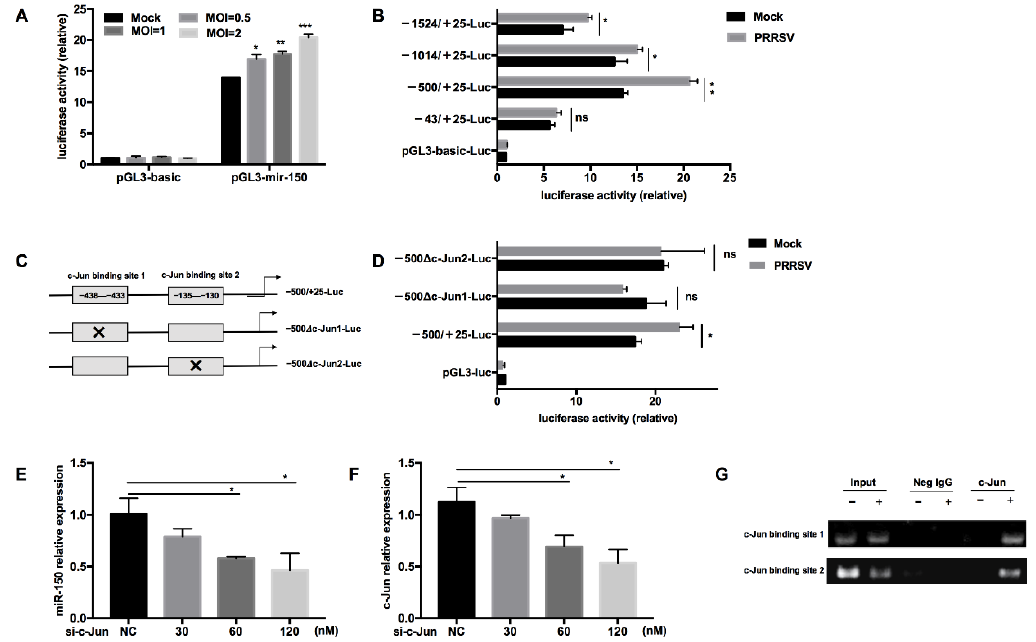
Figure 3. c-Jun is crucial for PRRSV to activate the miR-150 promoter. ( A , B ) After co-transfection of pGL3-miR-150 or truncated pGL3-miR-150 along with pRL-TK into Marc-145 cells for 12 h, cells were infected with HV-PRRSV (HV isolate) at an MOI of 1 or indicated MOIs. At 36 hpi, cells were